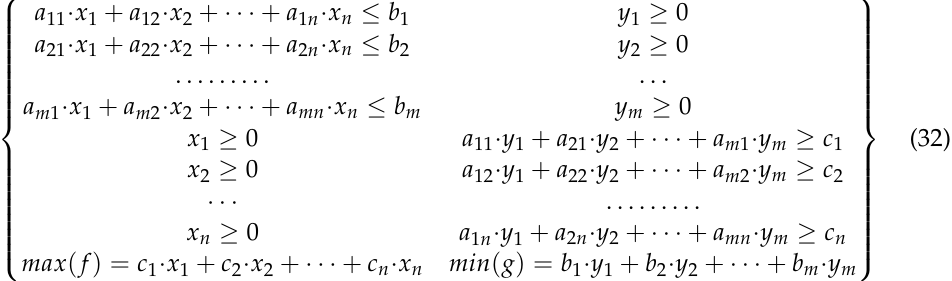
Figure 4. Distribution of fuel consumption between heat and electricity using different allocation methods. As alternative options for electricity and heat generation, the reference values pre- sented in the EU Regulation [44] for the same type of fuel were considered ( η Eref = 32% and η Href = 86%). It can be seen in Figure 4 that the power to heat ratio C (C = E/H) considerably influ- ences the allocation of fuel consumption in the case of the analyzed cogeneration plant. 0%10%20%30% 40%50%60% 70%80%90% 100%